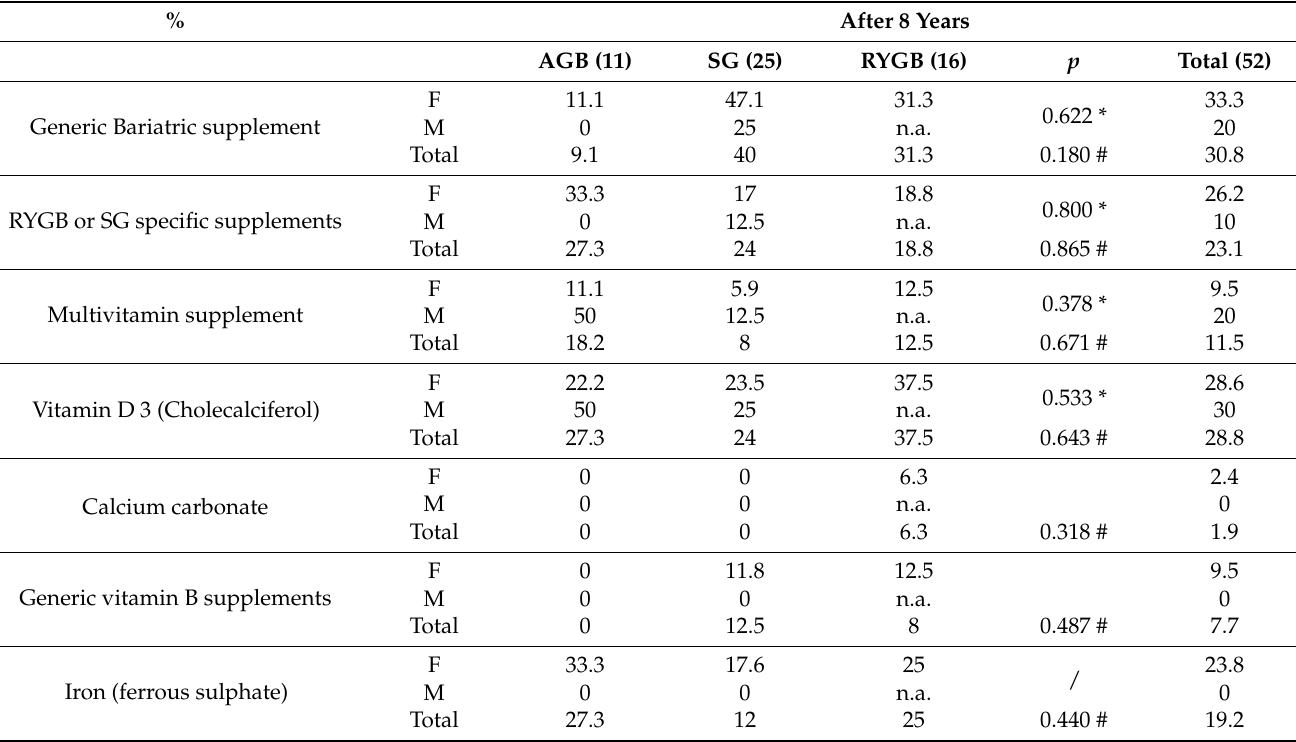
Table 5. Patients’ supplement use